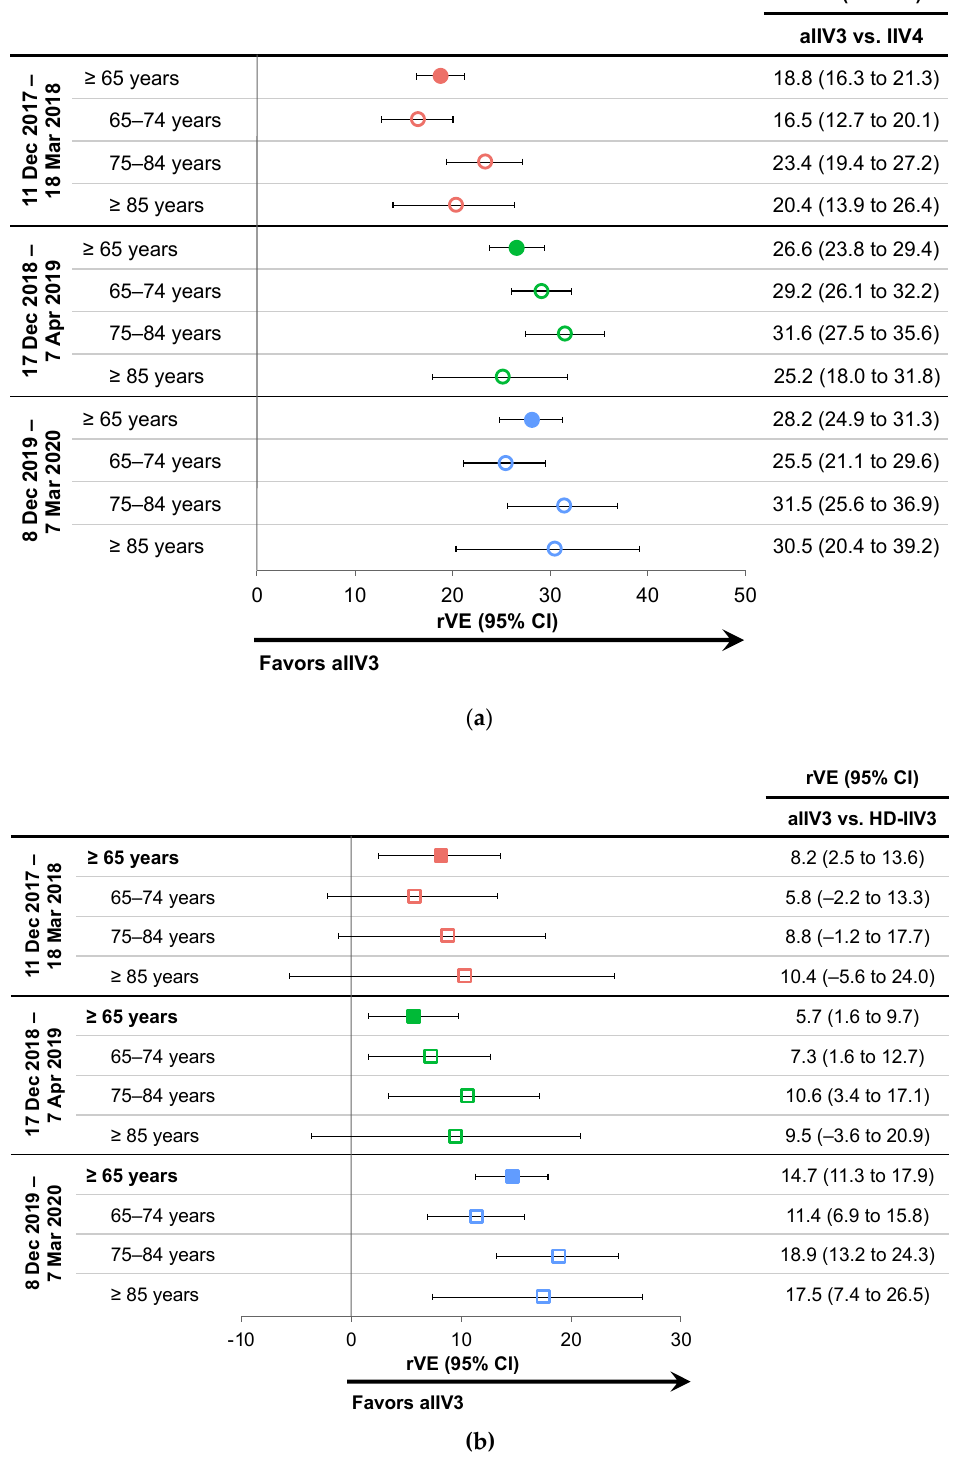
Figure 4. Relative vaccine effectiveness (rVE) of adjuvanted trivalent inactivated influenza vaccine (aIIV3) vs. comparators during periods of peak influenza activity between 2017 and 2020 in subjects ≥ 65 years of age and by age subgroups [22,24] . ( a ) aIIV3 vs. egg-based quadrivalent inactivated influenza vaccine (IIV4e); ( b ) rVE for aIIV3 vs. high-dose trivalent inactivated influenza vaccine (HD-IIV3). CI, confidence interval.